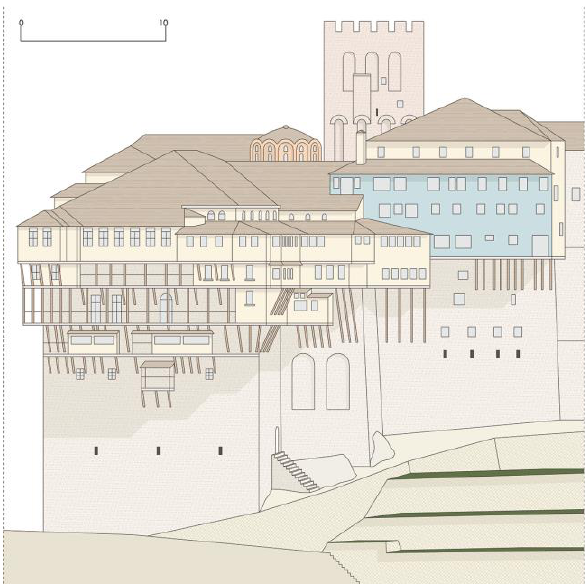
Figure 11 . The Monastery of St. Dionisio. Detail of the western